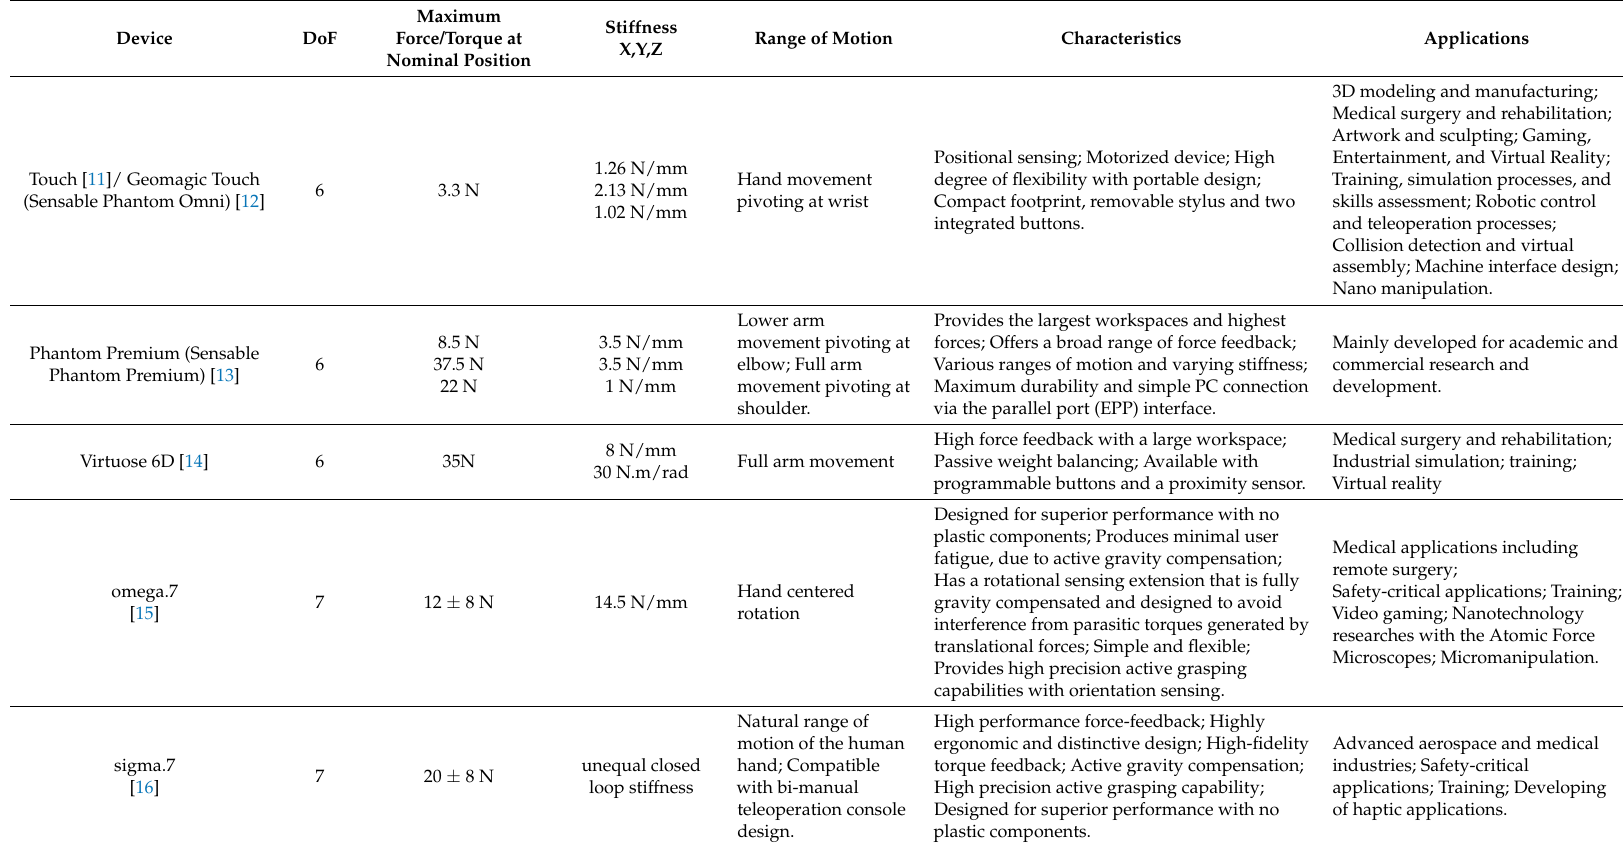
Table 1. Examples of available market haptic devices with their features and